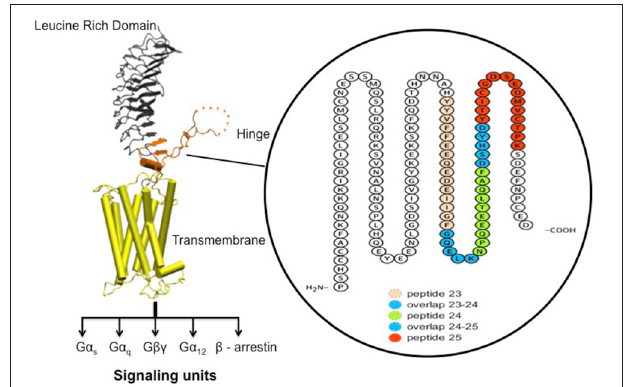
FIGURE 2 | Receptor structure and hinge region amino acid sequence. (Left) Model of the full-length human TSH receptor showing the major concave leucine-rich domain (gray), the large hinge region (orange) connecting to the helical transmembrane domain (yellow) with its short carboxyl tail and extra- and intra- cellular loops ( 25). The intracellular loops of receptor harbor sites for downstream effectors such G α s, G α q, G βγ , G α 12, and recruitment of β -arrestins thus forming the array of signaling units of the TSHR. (Right) A magnified image with amino acid sequence of the hinge region (aa 280–410) of the receptor with the “hot-spot” peptides marked in color. Shown here are the 3 “hot-spots” of the hinge region described in this study: peptide 23 (residues 352–371), peptide 24 (residues 367–386), and peptide 25 (residues 382–401) with there overlapping regions indicated in blue here. Note the 50 amino acid cleaved region (amino acids 316–366- indicated as dotted line in the above model) of the hinge has an overlap with peptide